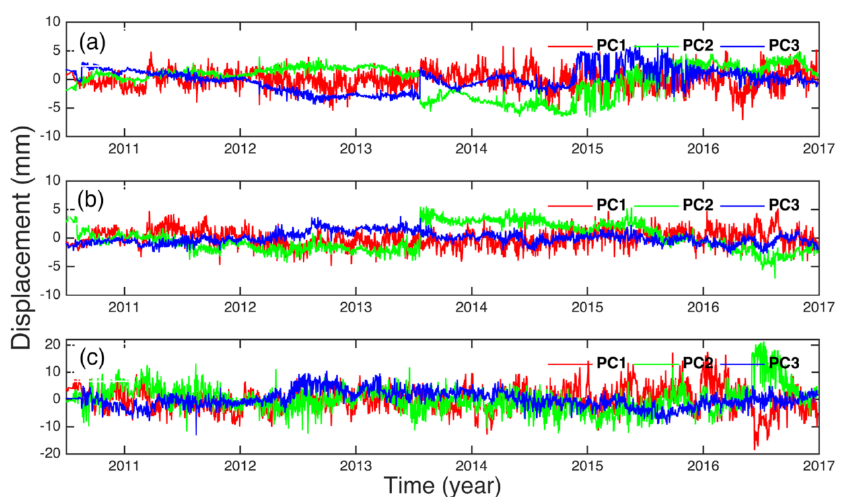
Figure 3. Time series of the first three principal components decomposed by PCA from regional GPS time series. ( a – c ) denote the east, north, and up directions,